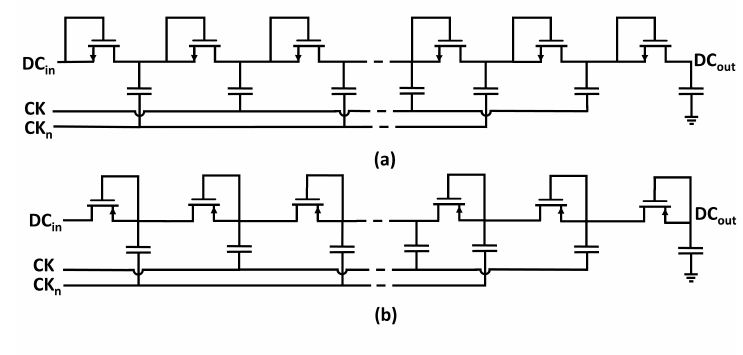
Figure 2. Circuit schematic of ( a ) Negative-Channel Metal Oxide Semiconductor (NMOS) and ( b ) Positive- Channel Metal Oxide Semiconductor (PMOS) implementations of a multi-stage Dickson